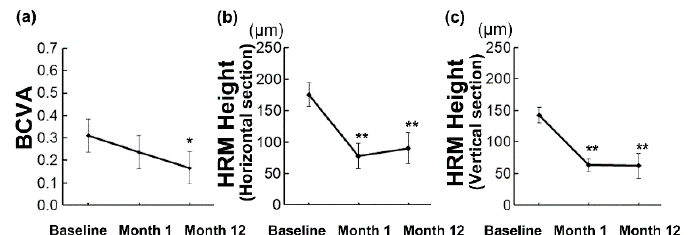
Figure 1. Changes in the best-corrected visual acuity (BCVA) and height of hyperreflective material (HRM) in the optical coherence tomography images over time. ( a – c ) Mean ± standard errors are shown. Generalized analysis of variance was performed. Overall, the mean BCVA improved at 12 months ( a ), while the mean HRM heights improved as early as 1 month after the initial treatment and the effect was still present at 12 months ( b , c ). * p < 0.05, ** p < 0.01.